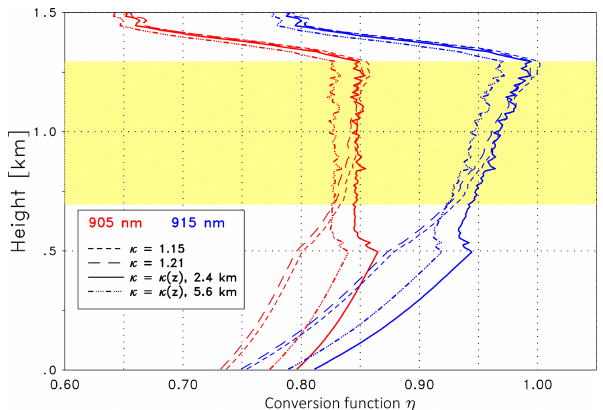
Figure 11. Conversion function η at 905nm (red) and 915nm (blue) for Case A: the short- and long-dashed lines are for constant κ with 1.15 and 1.21, respectively. The solid and dashed-dotted lines are calculated with a height-dependent κ(z) when applying β p profiles inverted from RALPH measurements with different reference val- ues. S p = 55sr is assumed in all cases. The validation range be- tween 0.7 and 1.3km is highlighted in yellow (see text for